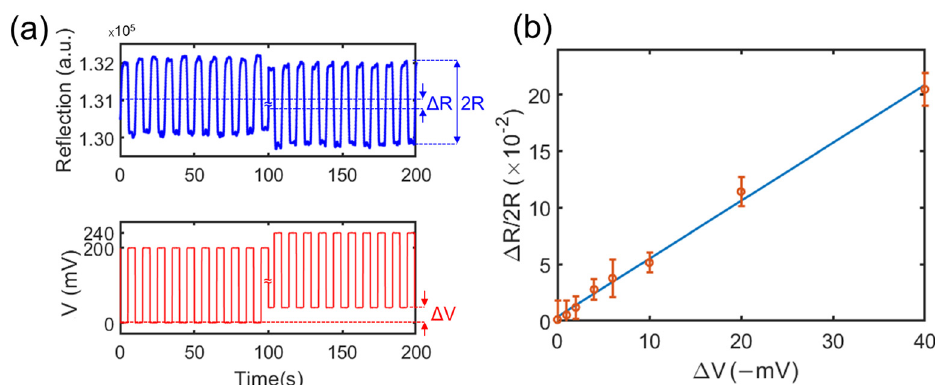
Figure 3. ( a ) Reflection intensity of a microelectrode with the changing of the applied voltage V = V w − V re , which is the voltage difference between the working and reference electrodes. The measurement was conducted in DI water. ( b ) The normalized reflection intensity changes as a function of the modulation amplitude ∆ V